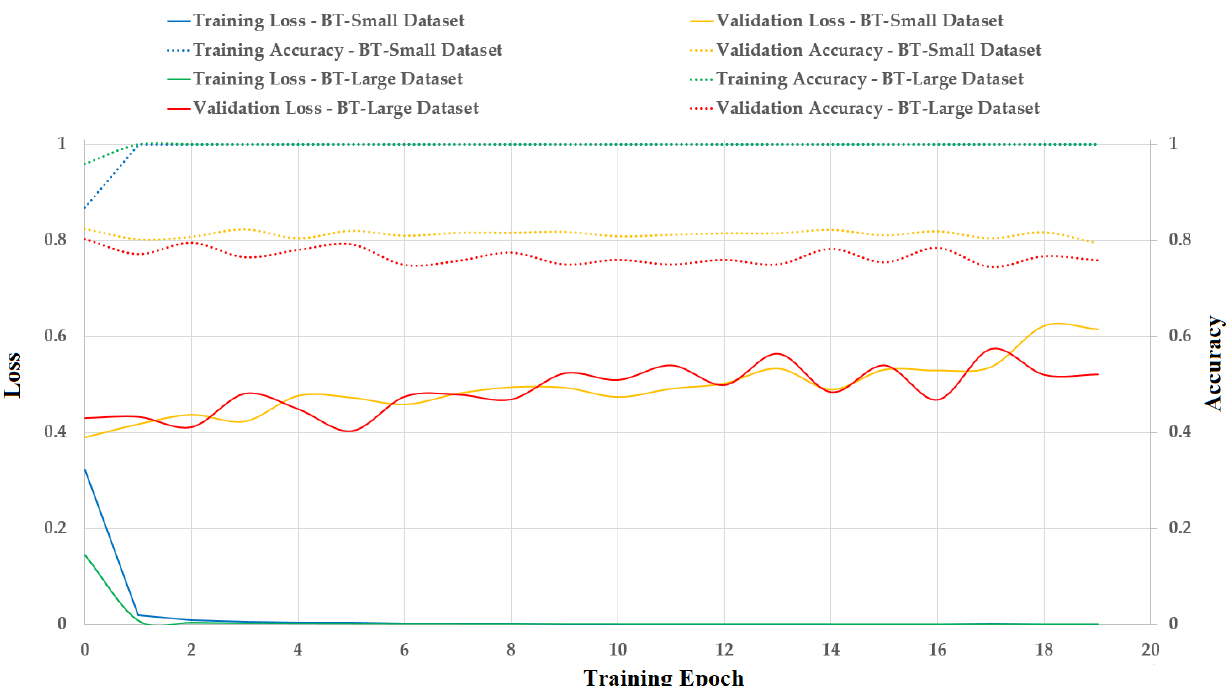
Figure 9. Training and validation curves (loss and accuracy) of the MLP network with the BT-Small and BT-Large datasets.